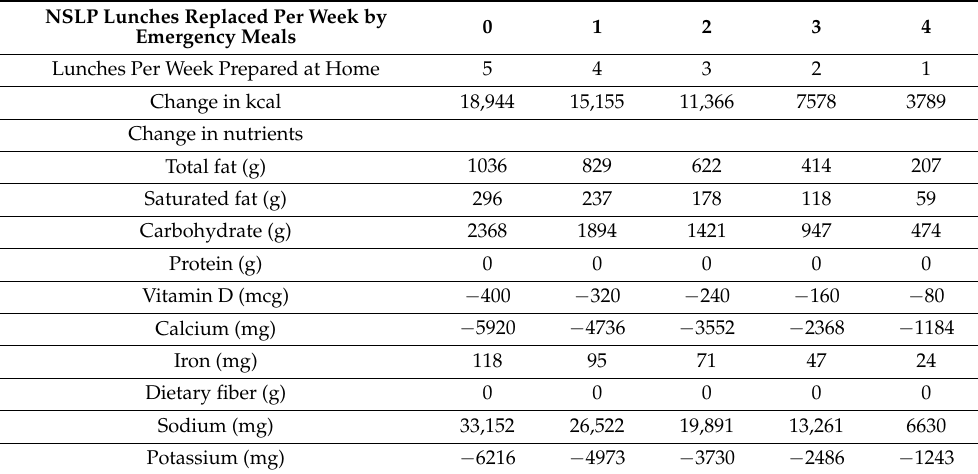
Table A2. Estimated total population-level change in weekly lunchtime calories and nutrients consumed by National School Lunch Program participants (n = 29.6 million) nationwide, assuming 0–4 lunches weekly are replaced through COVID emergency meal distribution sites serving meals that meet the National School Lunch Program